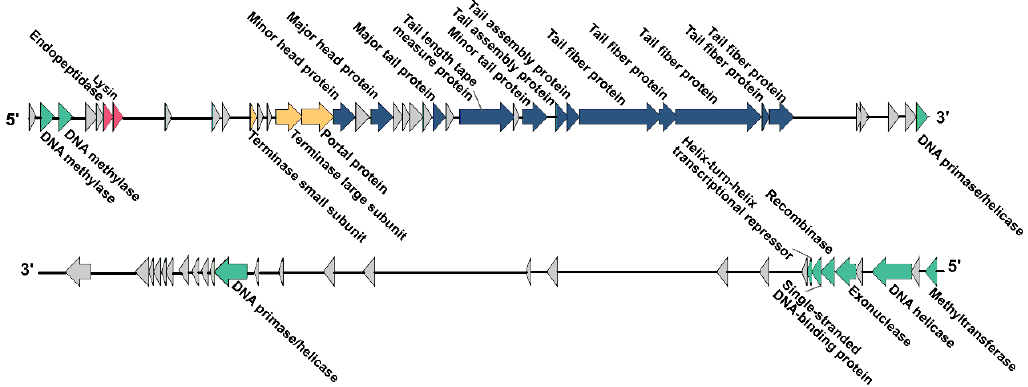
Figure 3. Genome organization of the vB_KleS-HSE3 phage. Different colors indicate four different gene modules: the DNA packaging gene module (orange color), the structural gene module (dark blue color), the nucleic acid metabolism associated gene module (light green color), and the cell lysis associated gene module (red color). Genes with unknown functions are indicated by a gray color.